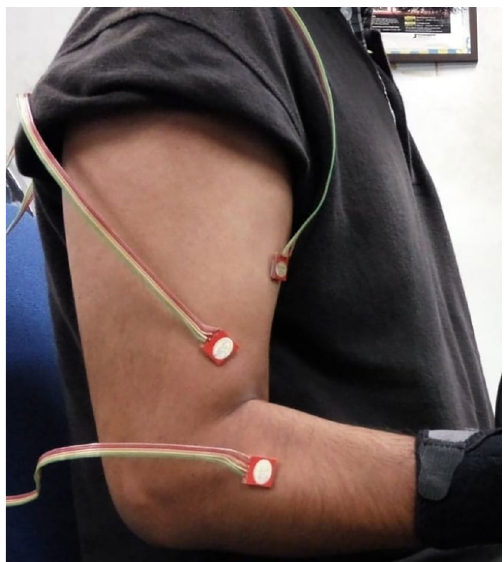
Figure 1. Placement of accelerometers on three elbow flexor